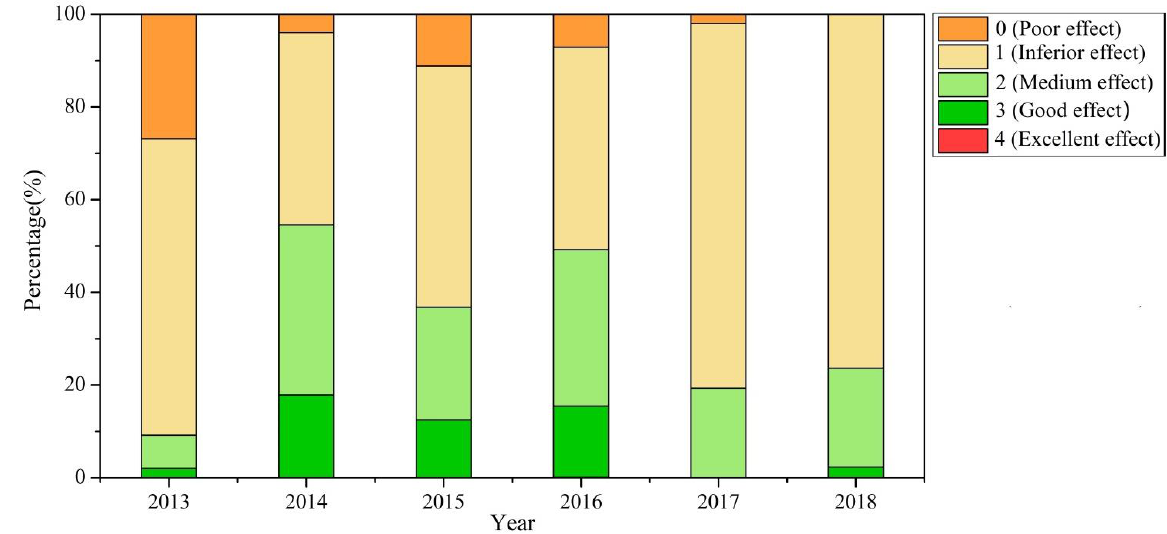
Figure 12. Restoration vegetation effects of each year from 2013 to 2018 (0, 1, 2, 3, and 4 represent poor, inferior, medium, good, and excellent restoration effects, respectively).